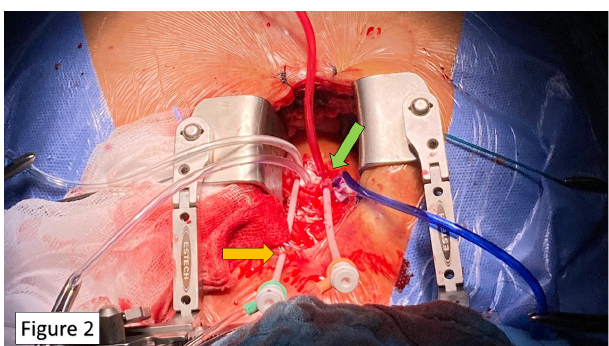
Fig. 2 - The 6-Fr sheath for the pigtail catheter is passed transcutaneously to stabilize the catheter-sheath unit (yellow arrow). Triple large purse-string sutures are performed on the ascending aorta at proper distance (green arrow).